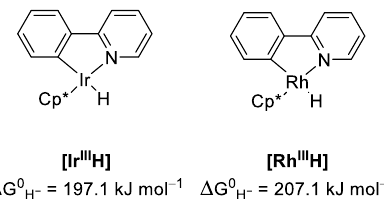
Figure 5. Hydrido complexes [Ir III H] and [Rh III H] (Cp* = C 5 Me 5 ) with their respective thermody- namic hydricity [42].